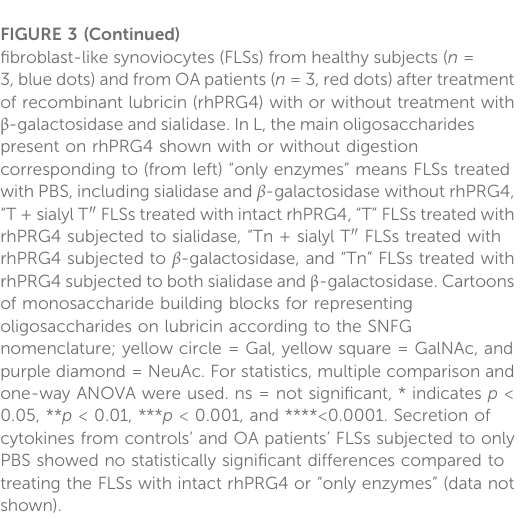
β -galactosidase and sialidase. In L, the main oligosaccharides present on rhPRG4 shown with or without digestion corresponding to (from left) “ only enzymes ” means FLSs treated with PBS, including sialidase and β -galactosidase without rhPRG4, “ T + sialyl T ″ FLSs treated with intact rhPRG4, “ T ” FLSs treated with rhPRG4 subjected to sialidase, “ Tn + sialyl T ″ FLSs treated with rhPRG4 subjected to β -galactosidase, and “ Tn ” FLSs treated with rhPRG4 subjected to both sialidase and β -galactosidase. Cartoons of monosaccharide building blocks for representing oligosaccharides on lubricin according to the SNFG nomenclature; yellow circle = Gal, yellow square = GalNAc, and purple diamond = NeuAc. For statistics, multiple comparison and one-way ANOVA were used. ns = not signi fi cant, * indicates p < 0.05, ** p < 0.01, *** p < 0.001, and **** < 0.0001. Secretion of cytokines from controls ’ and OA patients ’ FLSs subjected to only PBS showed no statistically signi fi cant differences compared to treating the FLSs with intact rhPRG4 or “ only enzymes ” (data not